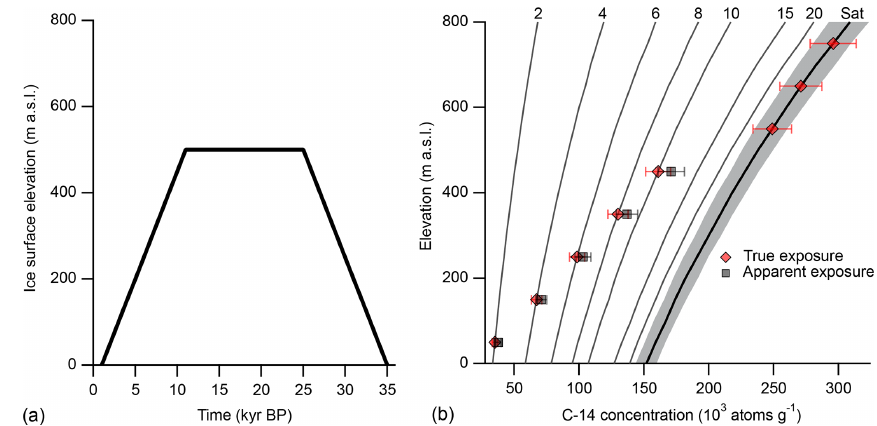
Figure 3. (a) Hypothetical ice surface elevation change at a nunatak partially covered by ice at the LGM. (b) Resulting in situ 14 C concen- tration, assuming no surface erosion, in samples collected at 100m intervals along an elevation transect on the surface of the nunatak. Thin black lines indicate isochrons of exposure duration. Thick black line with grey shading represents the saturation concentration and associated error envelope. Error envelope represents typical analytical uncertainty. “True exposure” refers to the resulting 14 C concentration associated with the ice surface change history on the left plot. “Apparent exposure” is the resulting concentration that includes an inherited component, which is a residual 14 C inventory remaining from the hypothetical samples which were saturated prior to ice